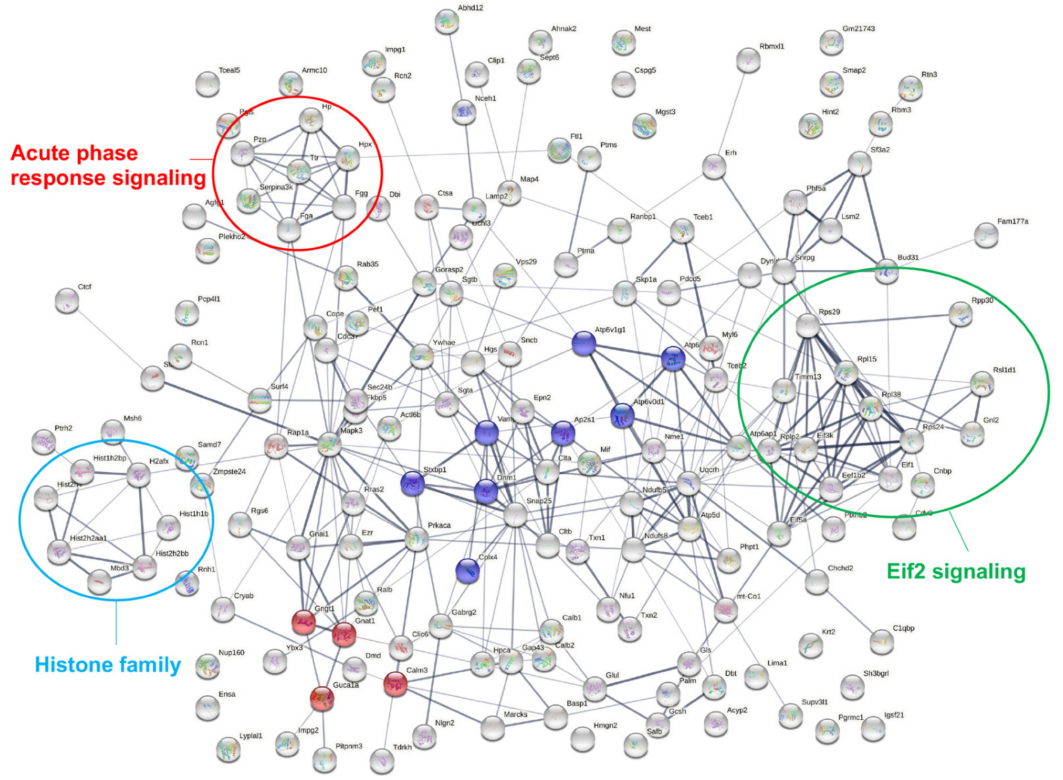
Figure 4. Interaction network analysis of all DEPs using STRING. The top two KEGG pathways are the “phototransduction” (mmu04744, molecules involved were labeled in red nodes) and the “synap- tic vesicle cycle” (mmu04721, molecules involved were labeled in blue nodes). Several signaling pathways with molecules clustered together were labeled with large circles, including acute phase response signaling (red circle), eif2 signaling (green circle), and histone family (blue